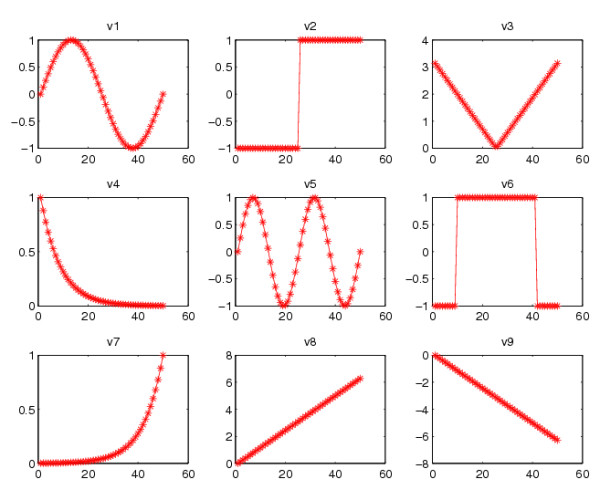
The nine signals.